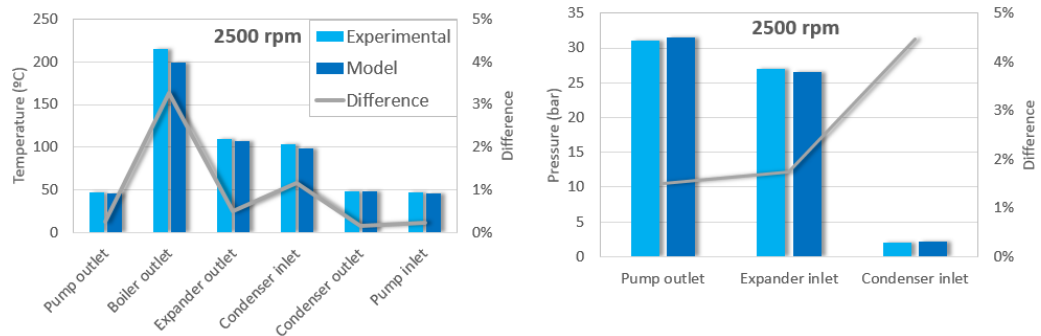
Figure 10. Validation of 2000 rpm.